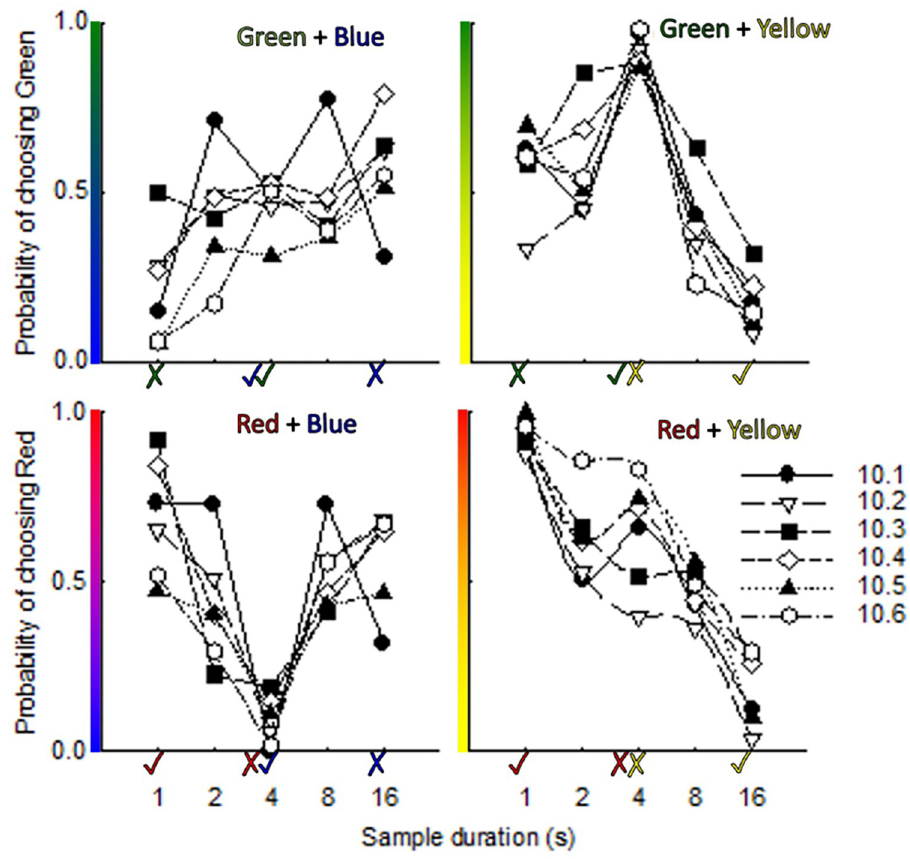
Fig 3. Probability of choosing comparison color in comparison and Sample + Comparison tests. Note: Colored ticks and crosses denote the sample duration at which choice of a comparison color was correct and incorrect (respectively) in training. Separate functions show data from individual